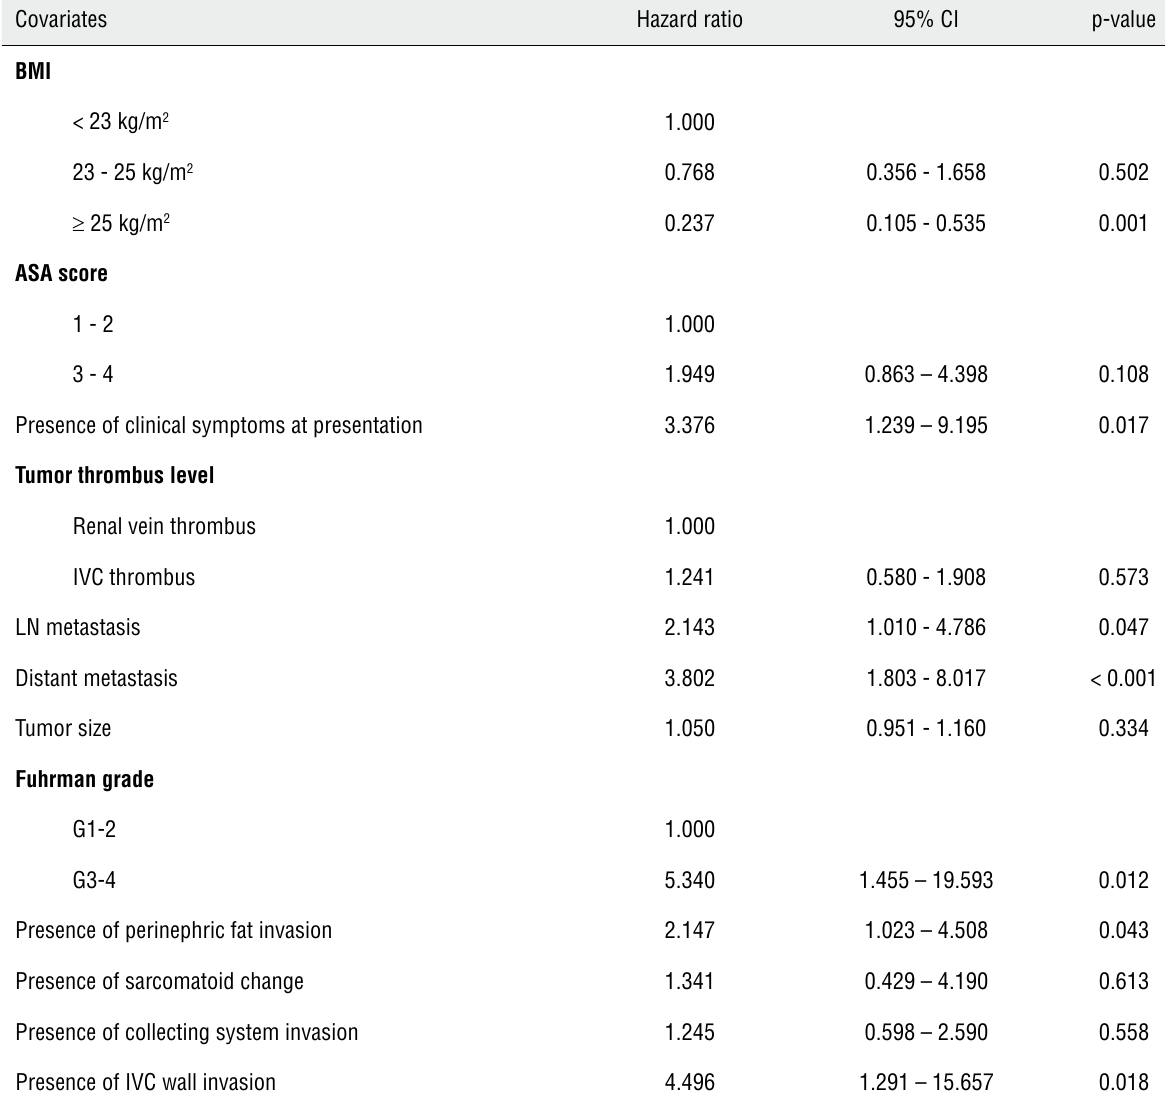
Table 2 - Multivariate Cox proportional hazard analysis for cancer-specific death in all patients.